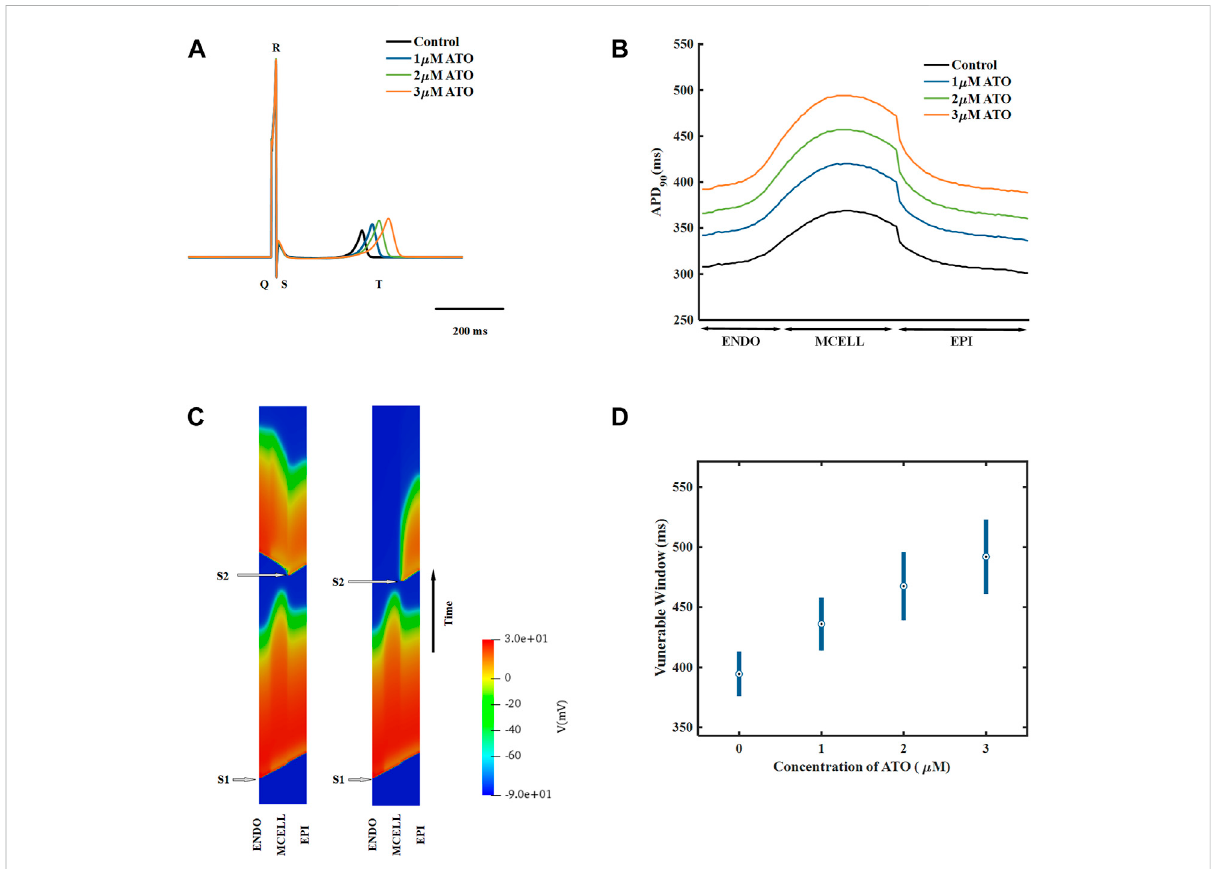
FIGURE 5 TheeffectofATOontheheterogeneousventricularcable. (A) ECGofventricularcableswithvaryingATOconcentrations. (B) Spatialdistribution of APD 90 across the ventricular cable with varying ATO concentrations. (C) Space-time plot of normal and unidirectionalconduction. (D) Vulnerable windows of ventricular cables under varying ATO